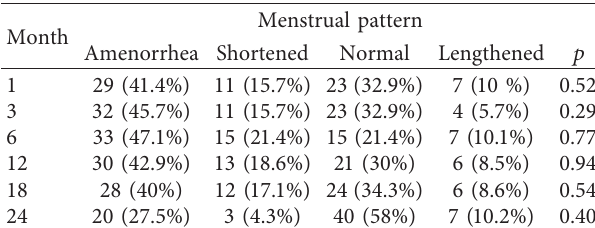
Table 3: Characteristics of menstrual pattern in two-rod